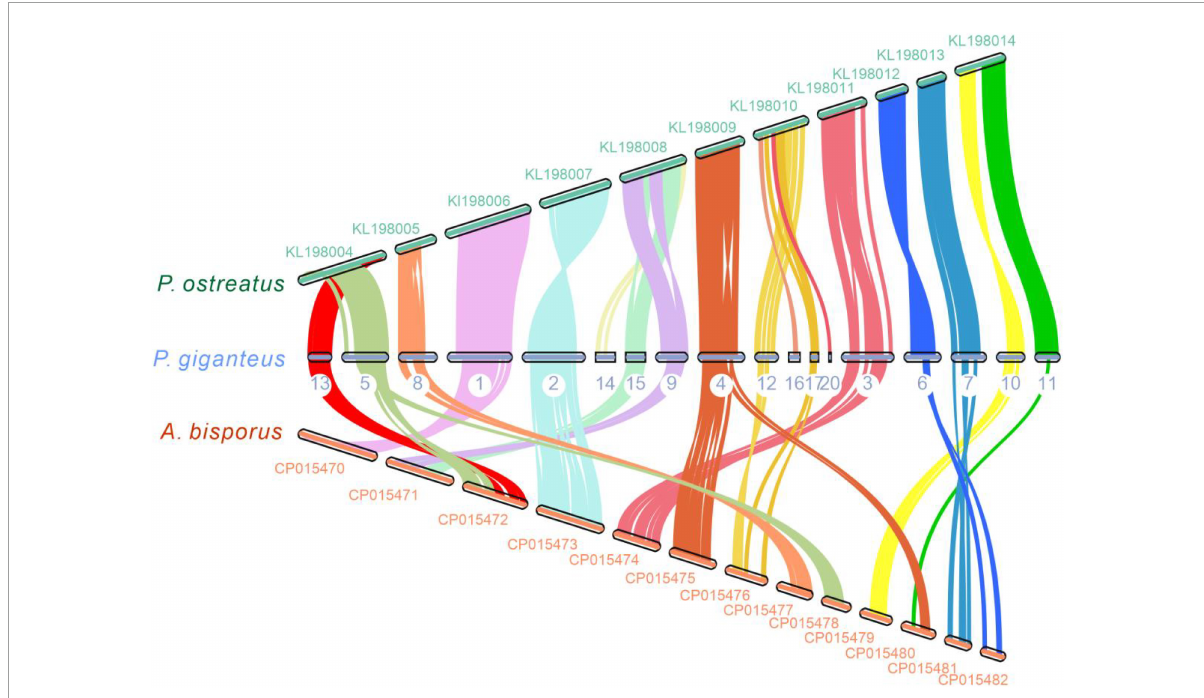
Figure 3 P. giganteus and P. tuber-regium shared 142 orthogroups that were missed in the other three species. Both P. giganteus and P. tuber-regium have a cup-shaped fruiting